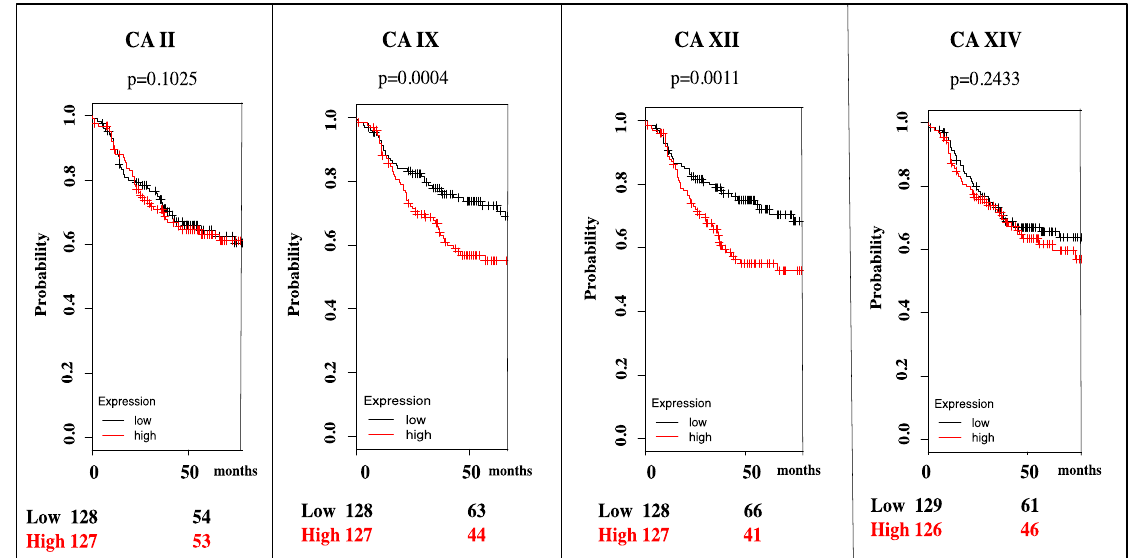
Figure 3. Survival plots for CA II, CA IX, CA XII, and CA XIV mRNA expression in triple negative breast cancer. Patients with high CA expression are represented in red and with low CA expression in black. High expression of CA XIV and off-target CA II does not have a significant effect on survival rate. Data shown to 70 months [53].